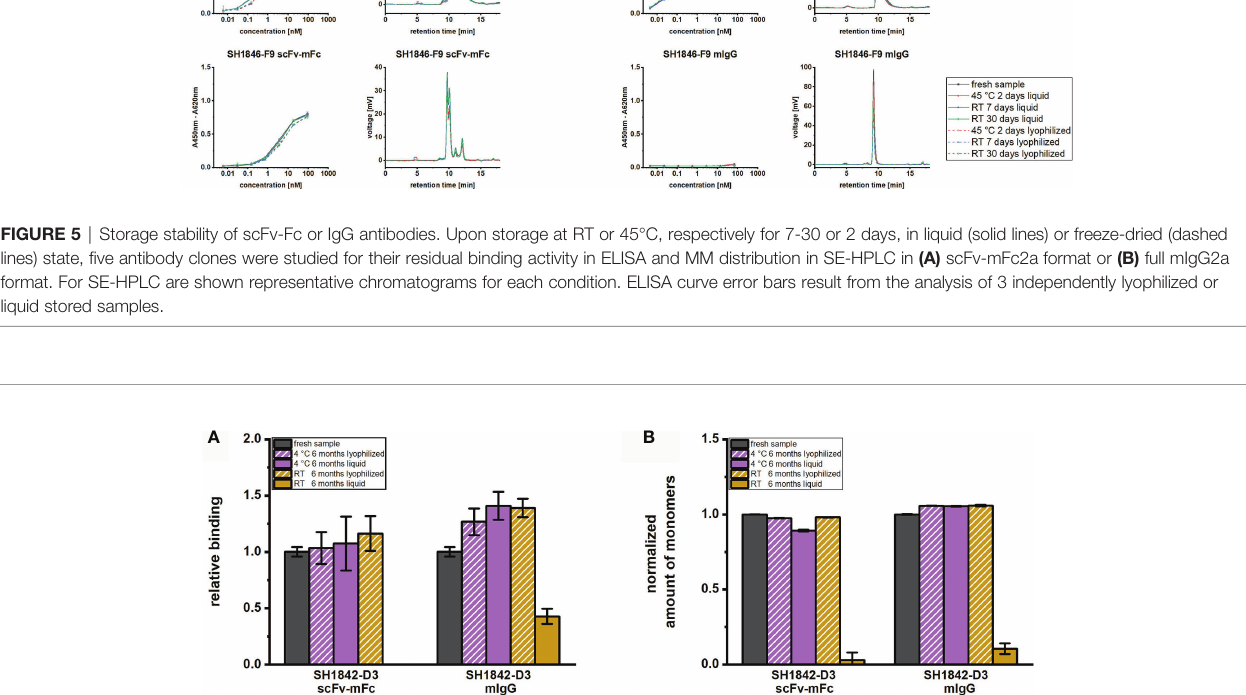
( Figure 1 and Table 1 ). While sodium phosphate, especially in the presence of sugar excipients, resulted in robust formation of cakes, formulations based on 1 x PBS, Tris-HCl or 0.1 M potassium phosphate buffers led indifferently to collapse of the cake structure.